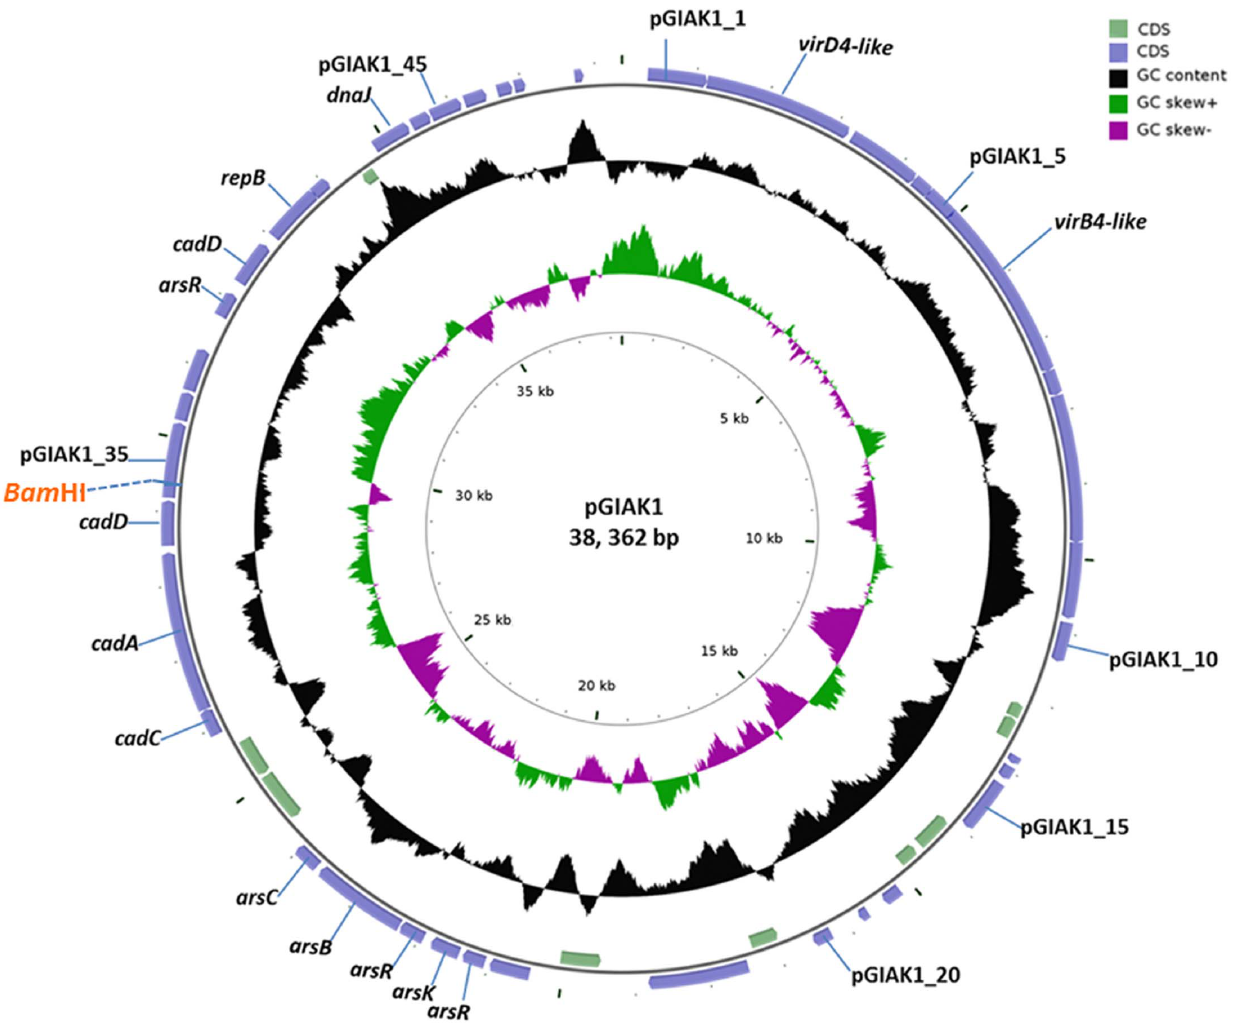
Figure 2. Physical and genetic map of plasmid pGIAK1. The map was visualized in CGView [44]. The outer circles indicate the predicted CDS. The blue and light green block arrows show the predicted genes with different transcription directions. The numbers beside the arrows indicate the corresponding genes. The black circle represents the GC content and the green/purple circles represent the GC-skew. The predicted genes involved in replication, cadmium resistance, arsenic resistance and conjugation are indicated. The single cloning site Bam HI is also indicated.